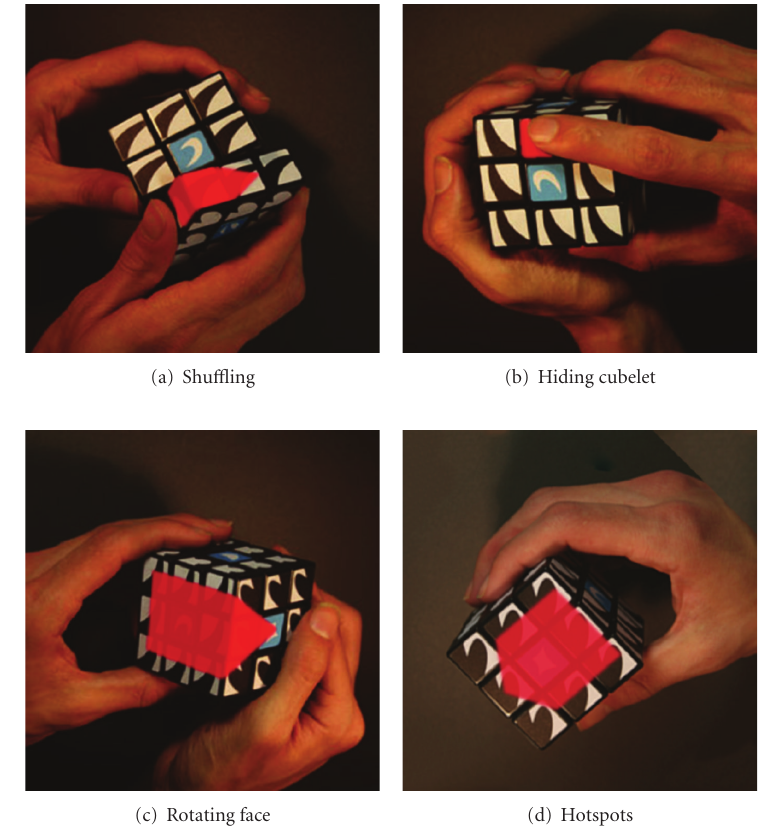
Figure 3: Interaction metaphors. (a) Shu ffl ing to change game assets; (b) hiding a cubelet to press a button; (c) rotating faces to see di ff erent views; (d) hotspots to choose between menu items.